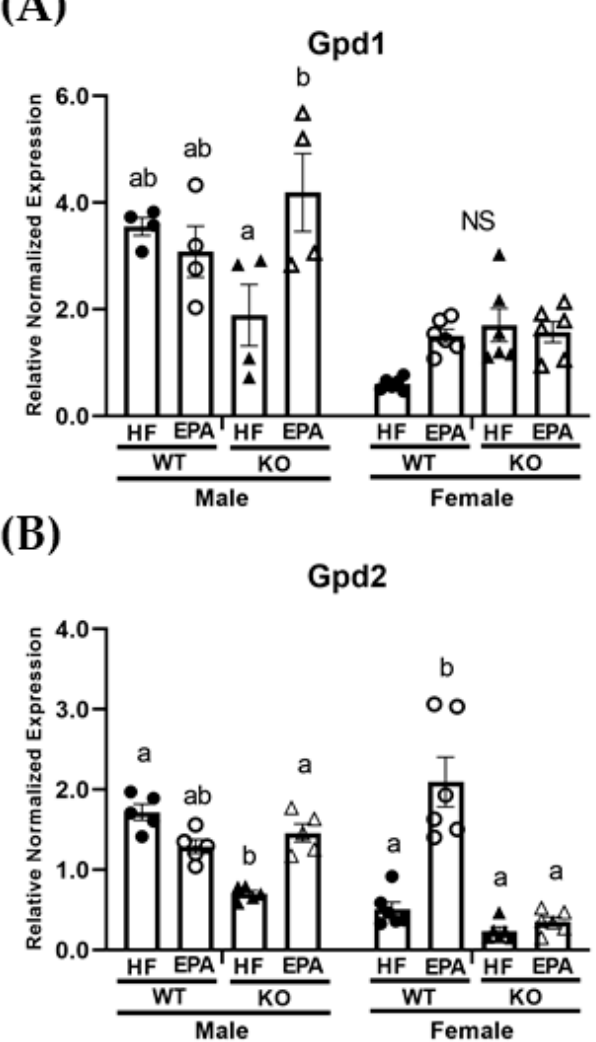
Figure 5. Sex-dependent effects on markers of metabolic futile cycling. mRNA levels of ( A ) glycerol 3-phosphate dehydrogenase (Gpd) 1 and ( B ) Gpd2 in the livers of male and female WT and UCP1 KO groups fed HF diets and EPA supplemented HF diets. ( A , B ) Data are expressed as mean ± SEM, n = 4–6; means without a common letter (a, b) differ in each male or female group; means with any common letter (a or b vs. ab) are not different from each other. NS indicates no significant post-hoc comparisons.